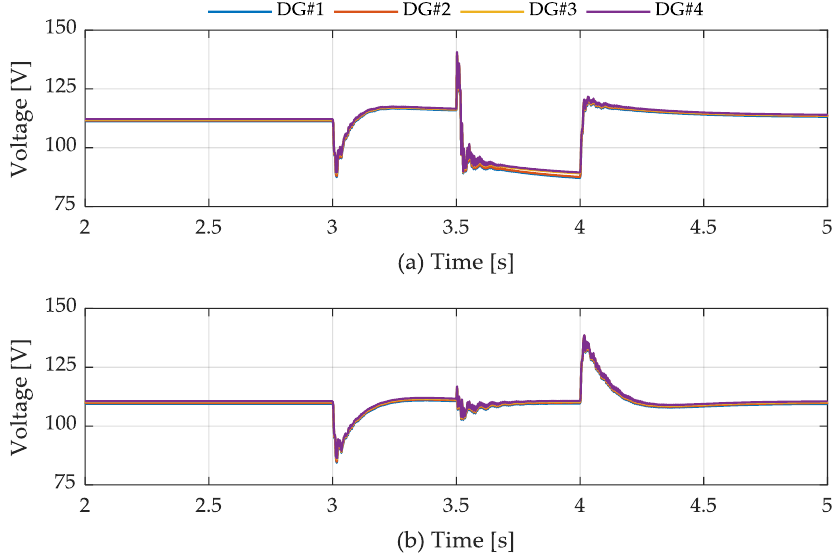
Figure 15. Output voltage of each DG: ( a ) centralized method; ( b ) proposed method.